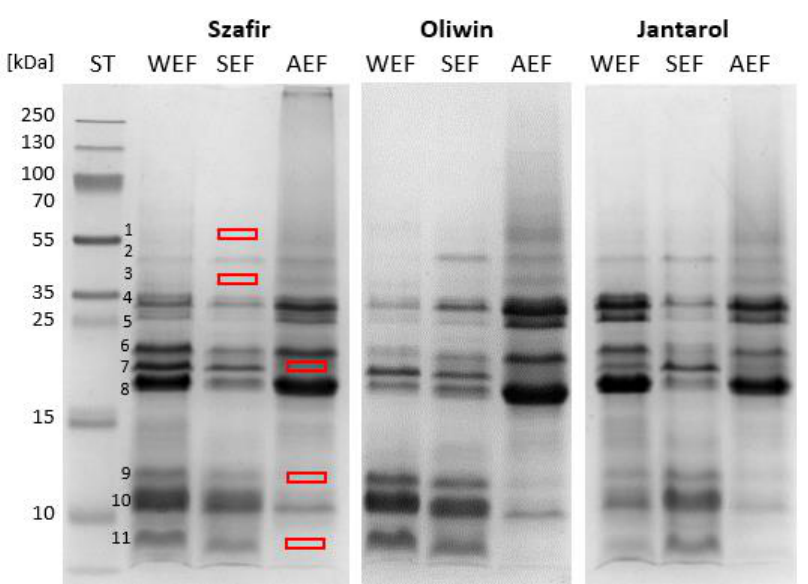
Figure 2. SDS-PAGE profiles of the flaxseed protein fractions. ST — standard, molecular weight [kDa]; WEF — water-extracted fraction; SEF — salt-extracted fraction; AEF — alkaline-extracted fraction; Szafir, Oliwin and Jantarol cultivars. The rectangles indicate the disappearing bands 1, 3 for SEF and 7, 9, 11 for AEF fractions, respectively.